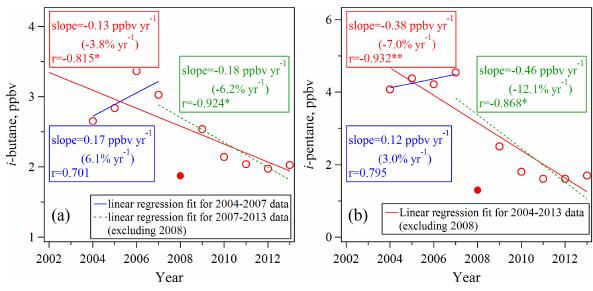
Figure 5. Temporal changes in ambient levels for (a) i -butane and (b) i -pentane measured at the PKU site during August from 2004 to 2013. The solid red lines represent linear regression fit for mixing ratios of i -butane and i -pentane during August from 2002 to 2013 excluding August 2008 data (the red filled circle). The dashed and solid blue lines represent linear regression fits for ambient measure- ments during August from 2004 to 2007 and during August from 2007 to 2013 (excluding August 2008 data),